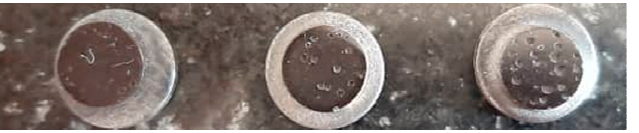
Figure 4. Images of the three-component composites with 5, 7 and 10% ( w / w ) LDH. Co-Zr LDH was proposed as a composite for cement bone because of the micro-sized particles of LDH and the mechanical properties of Zr. It was theorized that the micro size of LDH would prevent the concentration of tension and the decreasing strength of the composite. However, pores increased in size with increasing percentages of LDH. Thus, strength of the